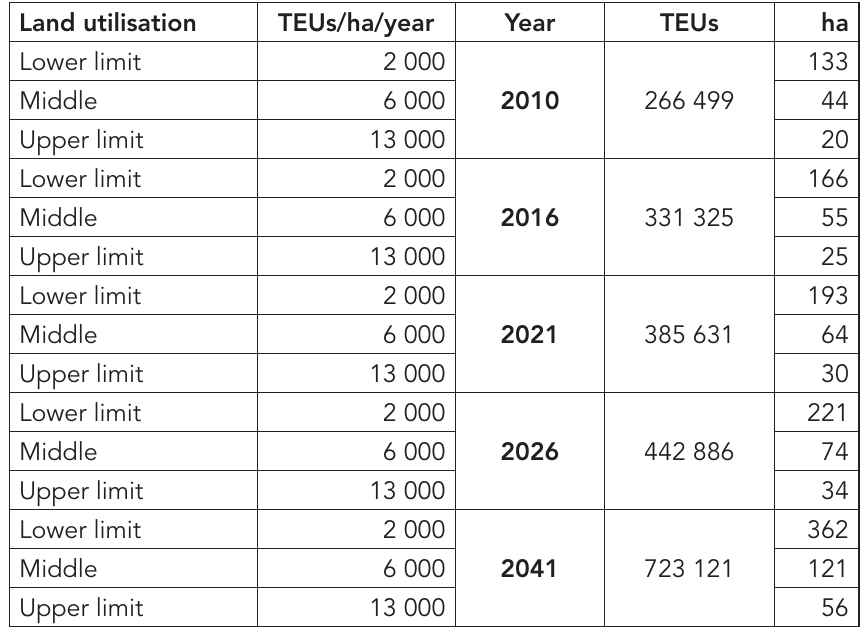
Table 4: Maximum future spatial requirements for the IICT Land